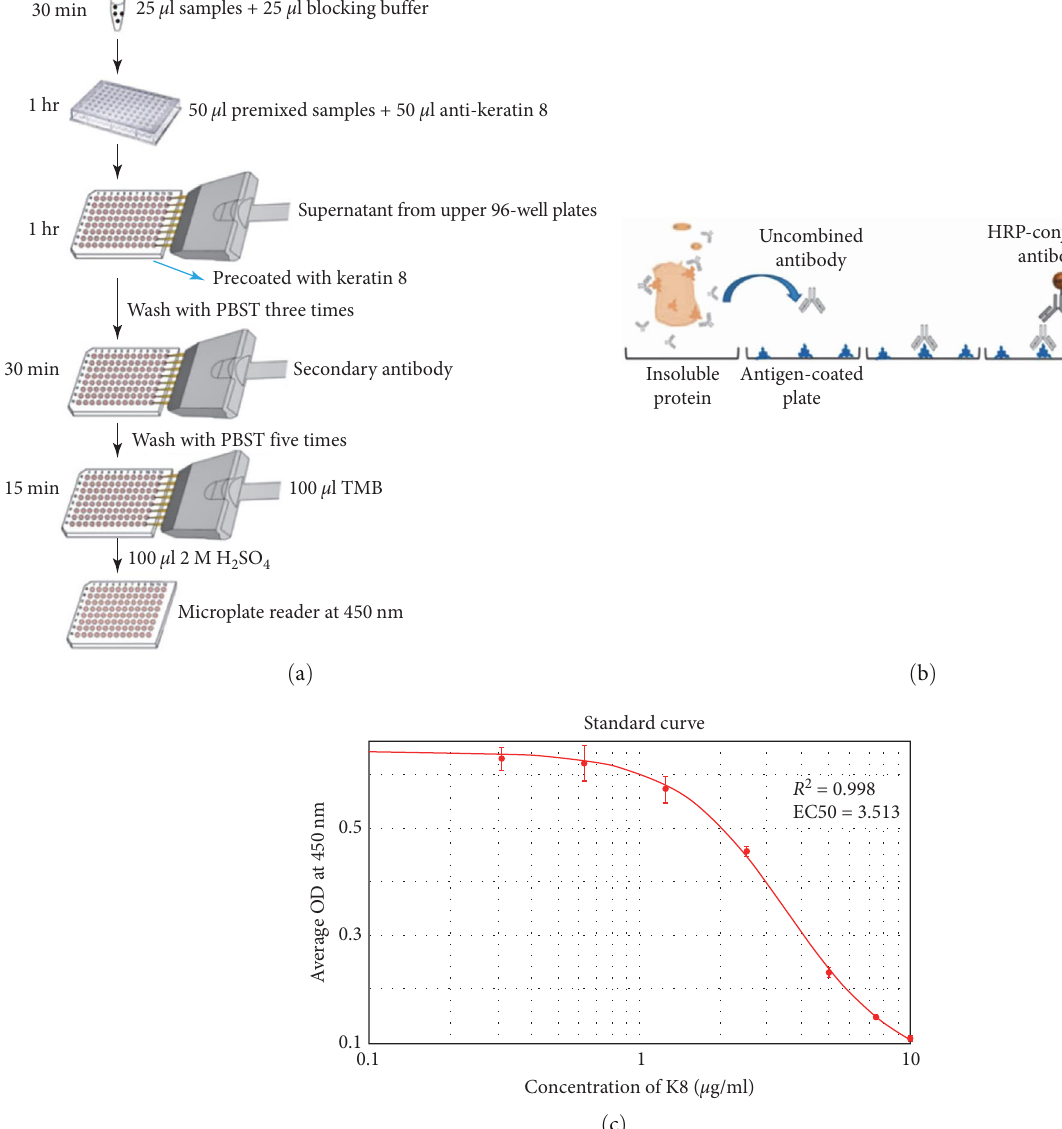
F IGURE 1: Modi fi ed ELISA protocol to measure total K8 proteins in the stool: (a) particular operating procedures. The blocking buffer is composed of 5 % skim milk, PBST, and 1 % NP40. PBST, phosphate-buffered saline with Tween 20; TMB, tetramethylbenzidine; and H 2 SO 4 , sulfuric acid; (b) schematic diagram of the principle. Individual fecal samples were diluted to a suitable level in PBS/EDTA buffer within the measurement range of the assay. We con fi gured a new protocol by measuring the remaining amount of free unbound primary antibody after antigen – antibody reaction. K8 levels were calculated using 4-parameter nonlinear logistic curve fi tting (4-PL) to assess the total level of both insoluble and soluble K8; (c) standard curve of K8 (mean Æ SD). The plates, as shown in Figure 1(a), were read at 450nm with a reference fi lter at 620nm using the SpectraMax ® i3x Multi-Mode Microplate Reader. OD, optical density; K8, keratin 8. Note that a routine sandwich ELISA cannot measure the insoluble K8, which may account for 95 % of the total amount. The new ELISA protocol can assess total fecal K8 with the majority of insoluble